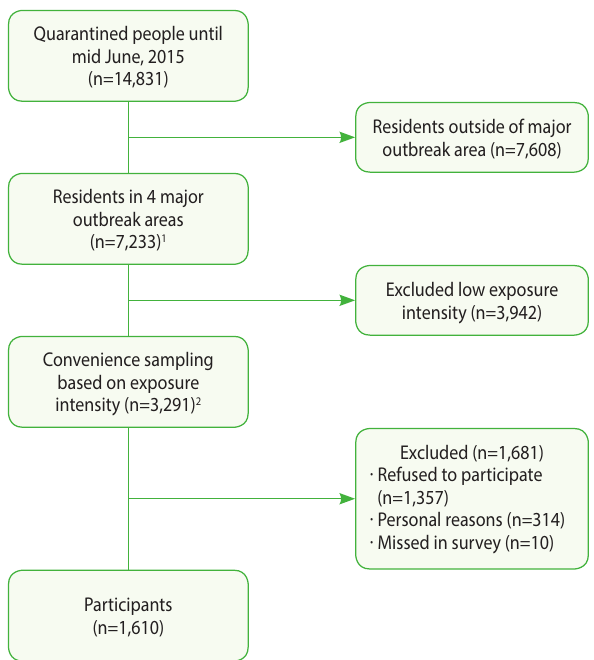
Figure 1. Flowchart of participants in the Middle East Respiratory Syndrome (MERS) serologic survey in Korea. 1 Major MERS outbreak areas including Seoul, Gyeonggi, Chungcheong, and Jeonbuk in Korea. 2 Selection rates were different by characteristics of exposed MERS case and status of subjects (see the Table